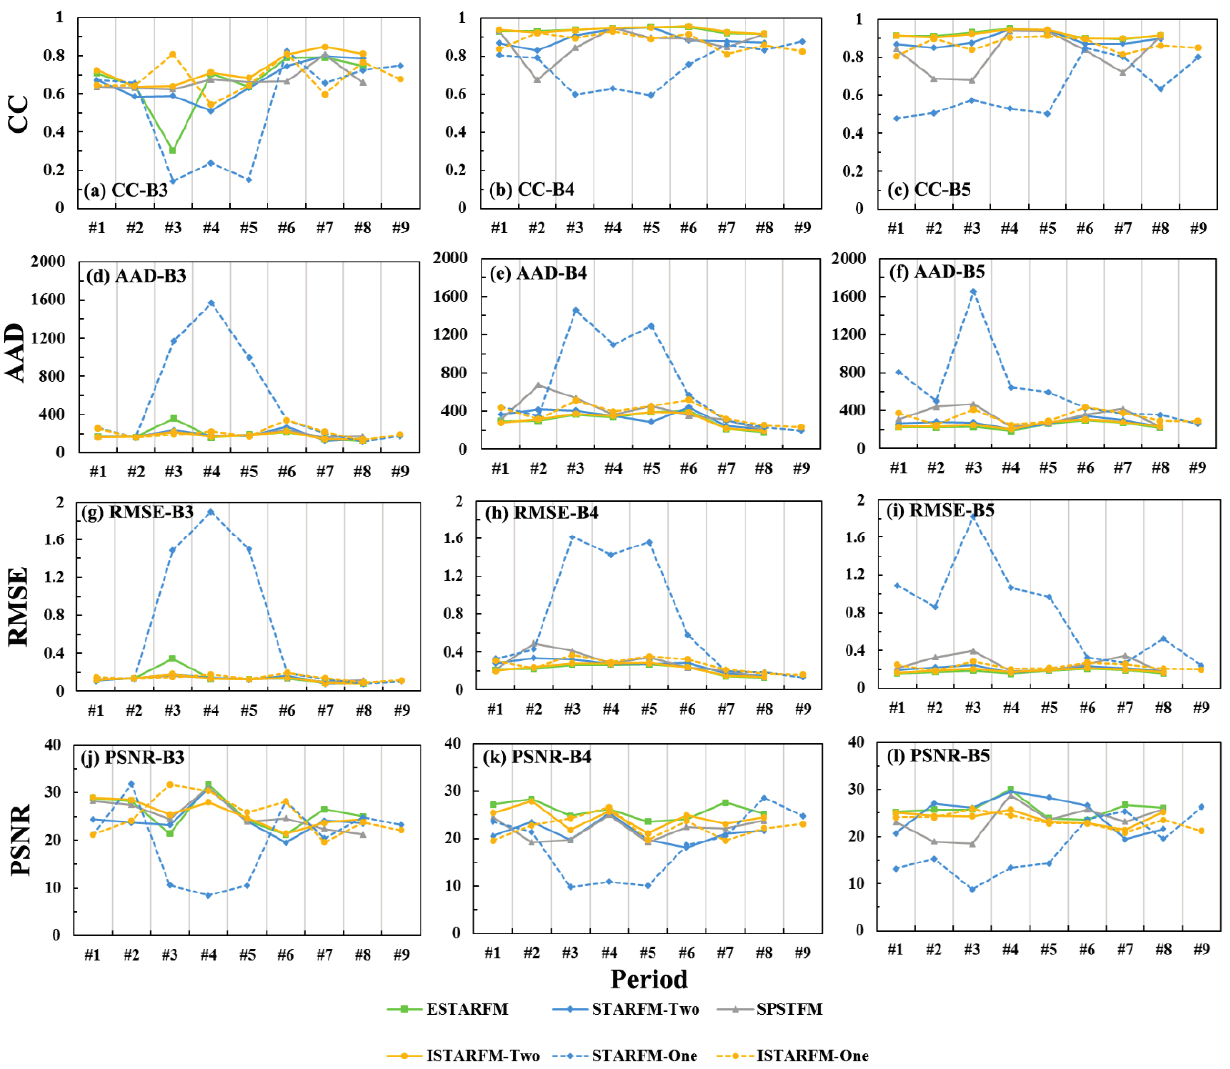
Figure 10. “Curve” visualization of individual accuracy measures of the time-series predictions for the Poyang Lake site, showing the accuracy measures: CC ( a – c ); AAD ( d – f ); RMSE ( g – i ); and PSNR ( j – l ).